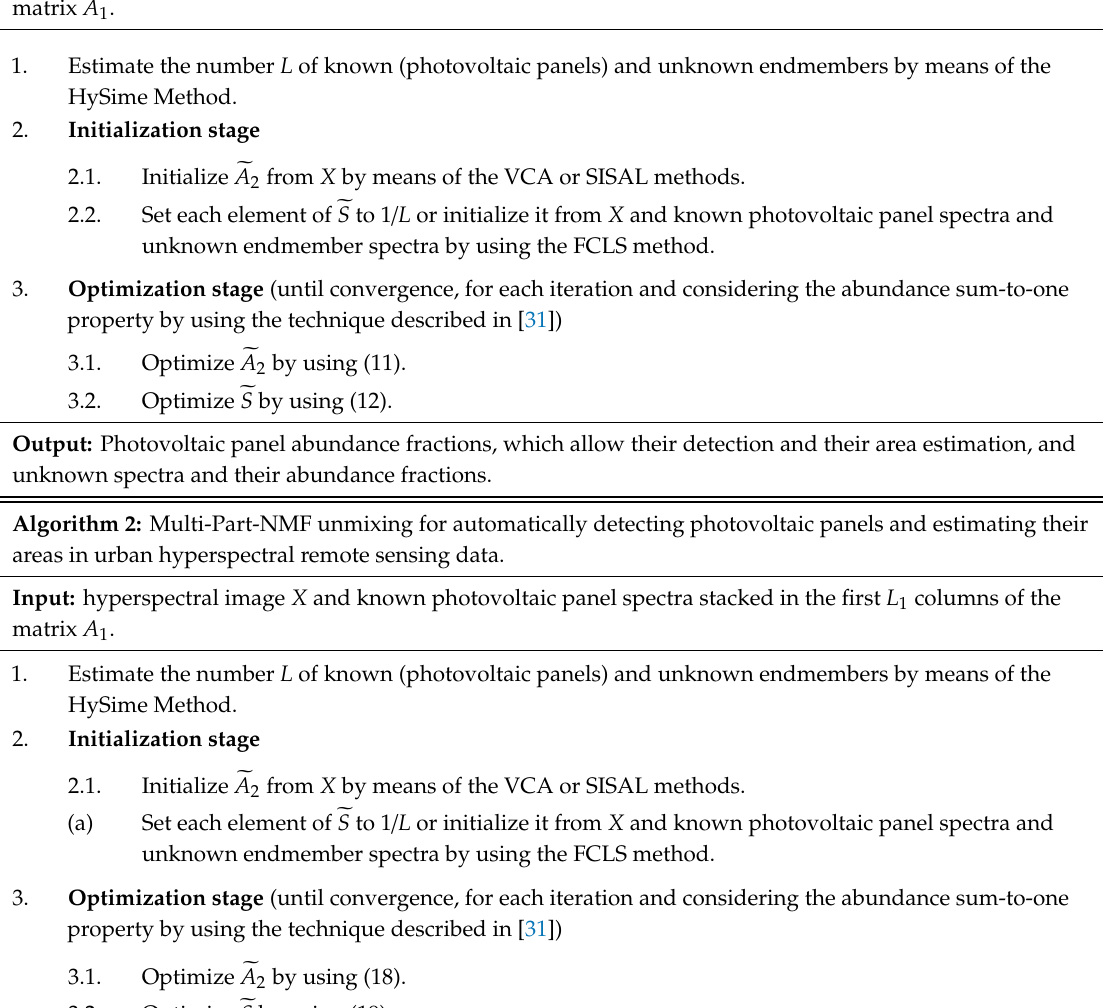
Algorithm 1: Grd-Part-NMF unmixing for automatically detecting photovoltaic panels and estimating their areas in urban hyperspectral remote sensing data.